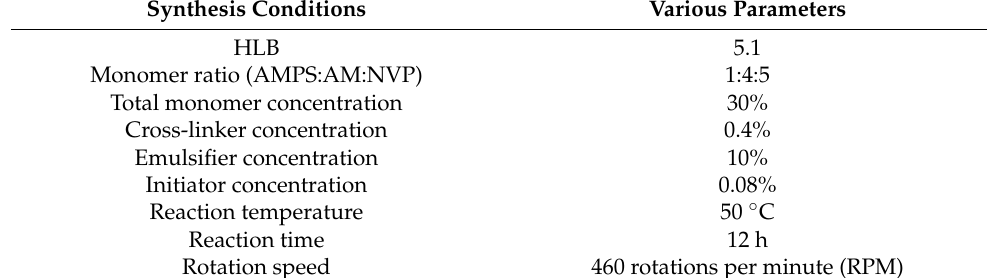
Table 2. The synthesis conditions of AMN other than oil-water ratio.